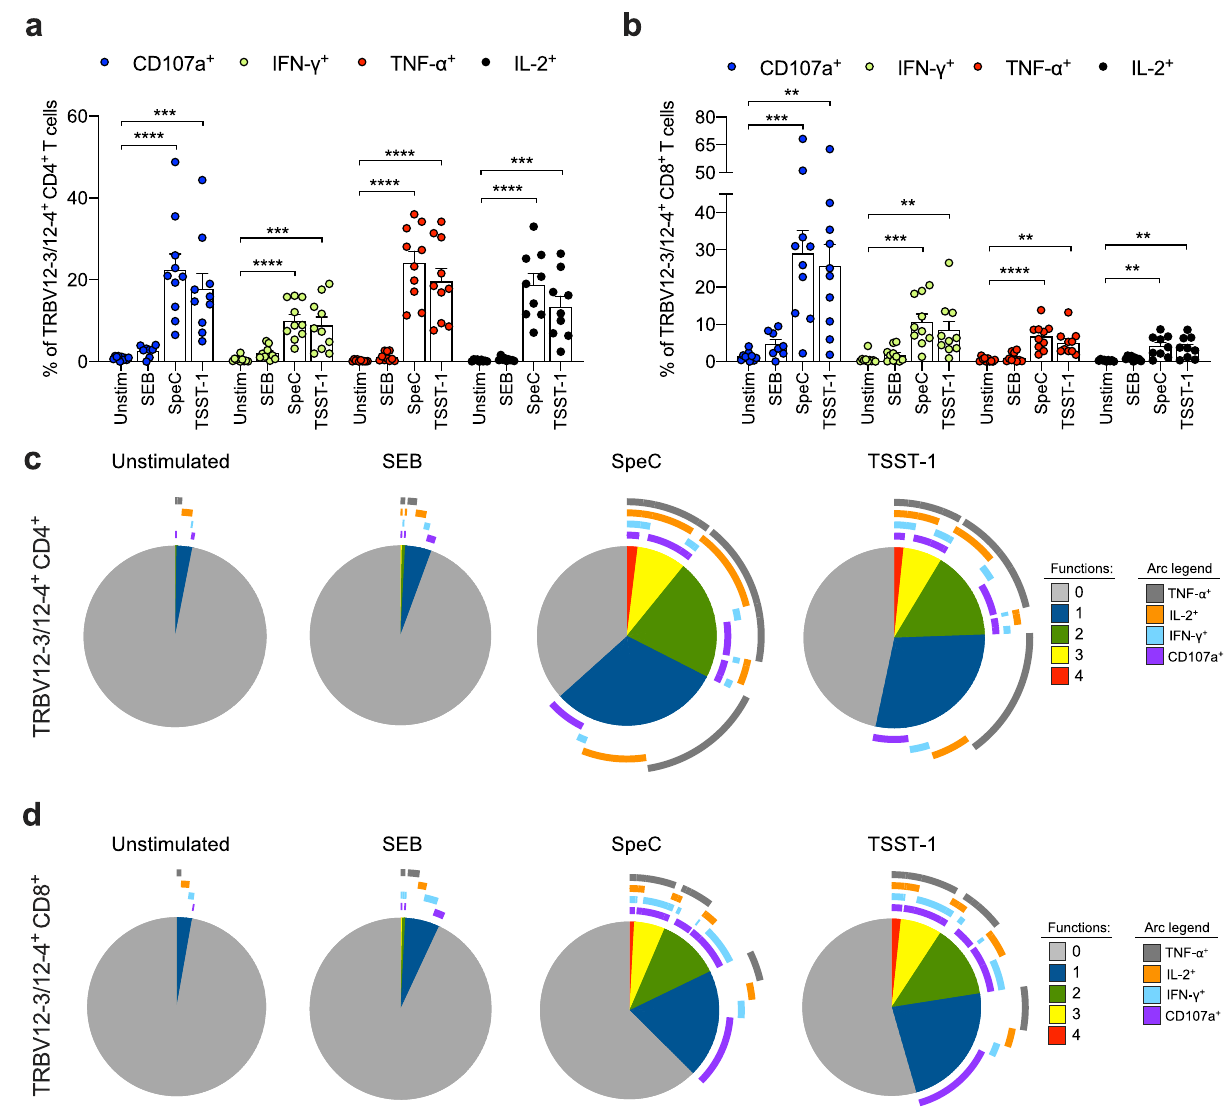
Fig. 2 SpeC and TSST-1 induce polyfunctional TRBV12-3/12-4 + CD4 + and CD8 + T cells. a , b Frequency of CD107a + (blue fi lled circles), IFN- γ + (green fi lled circles), TNF- α + (red fi lled circles), or IL-2 + cells (black fi lled circles) among TRBV12-3/12-4 + CD4 + ( a ) or CD8 + T cells ( b ) from human PBMCs cultured in medium alone (unstim) or stimulated for 24 h with SEB, SpeC, or TSST-1. Each dot represents one donor. Data are shown as mean ± SEM. ** p < 0.01, *** p < 0.001, **** p < 0.0001. One-way ANOVA with Tukey ’ s post-hoc test. c , d Functional pro fi les of TRBV12-3/12-4 + CD4 + ( c ) or CD8 + T cells ( d ) from human PBMCs cultured in medium alone (unstimulated) or stimulated for 24 h with SEB, SpeC, or TSST-1. Pie chart segments from concatenated data ( n = 4) represent the fractions of cells displaying the indicated numbers of functions (key). Arcs denote individual functions (key). The functional pro fi les elicited by SpeC and TSST-1 were signi fi cantly different from the corresponding functional pro fi les elicited by SEB ( p < 0.05; permutation